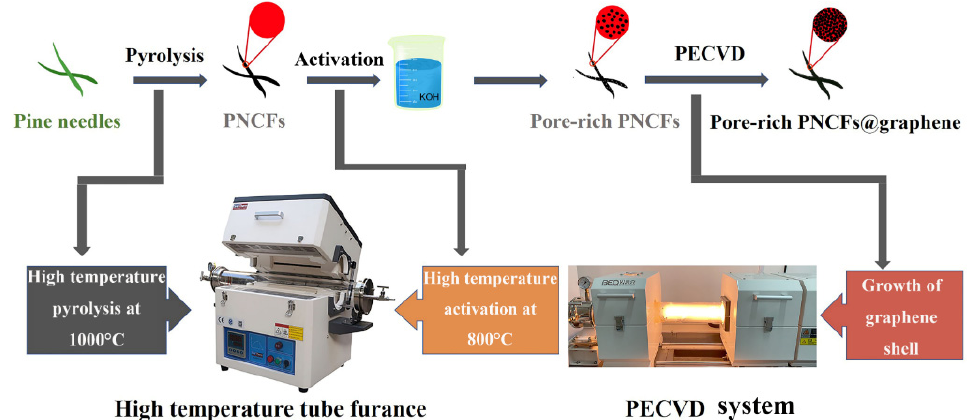
Figure 1. Schematic illustration of the design philosophy and synthetic strategy of the pore-rich PNCFs@graphene.